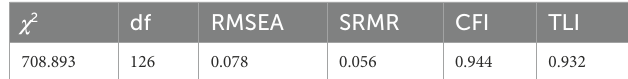
TABLE 3 Fit index of technology morality